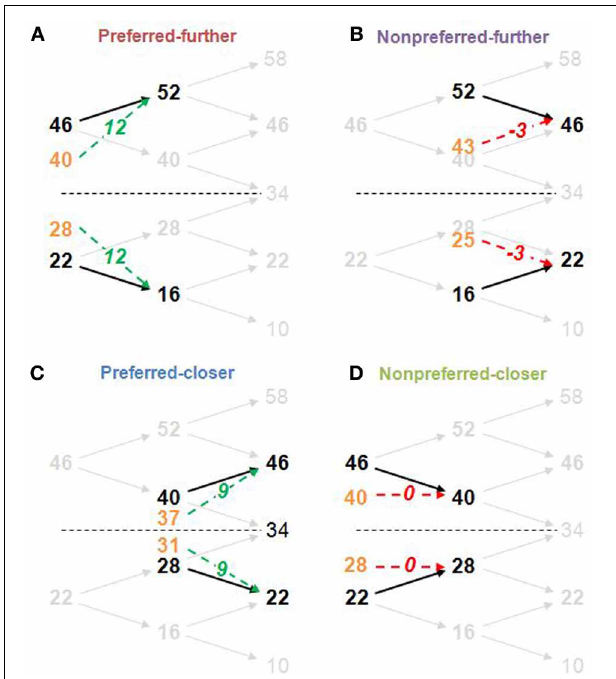
FIGURE 2 | Structure of derived stimulus-set for the main task and the four time-order/distance trial-types. The frequency difference between stimuli pairs was determined by the titration procedure (in this example, the frequency difference is 6Hz). Example trial-types (A , Preferred-further; B , Nonpreferred-further; C , Preferred-closer; D , Nonpreferred-closer ) are shown by thick black frequencies and arrows against the faded stimulus-set used in the task. Orange values show the midpoint between the first stimulus (Stim1) and the global mean (34Hz) and represents the “perceived drift” value of the first stimulus (perceived Stim1). The “perceived difference” due to this drift is represented by green dotted arrows for preferred time-order trials (more distinct), and by red dotted arrows for nonpreferred time-order trials (less distinct) with the perceived difference (second stimulus frequency minus the perceived Stim1) shown in italics. For example, for the nonpreferred-further trials, the perceived difference is “ − 3,” indicating that the first stimuli drifted to a position below that of the second stimuli. The “closer” trial-types are defined by a shorter distance between the first stimuli to the global mean compared to the “further” counterparts. The study structure design imposed an absolute maximum titrated frequency difference of 8Hz. Any participant exceeding this value after two attempts of the titration procedure was excluded from the study (see Titration procedure in Materials and Methods). Frequencies above and below the stimulus-set range (10 and 58Hz, and an additional frequency of 34Hz) ensured that participants compared the two vibrations for all other trials rather than making a categorical judgement about the frequency of the second vibration independently of the first (Hernandez et al.,